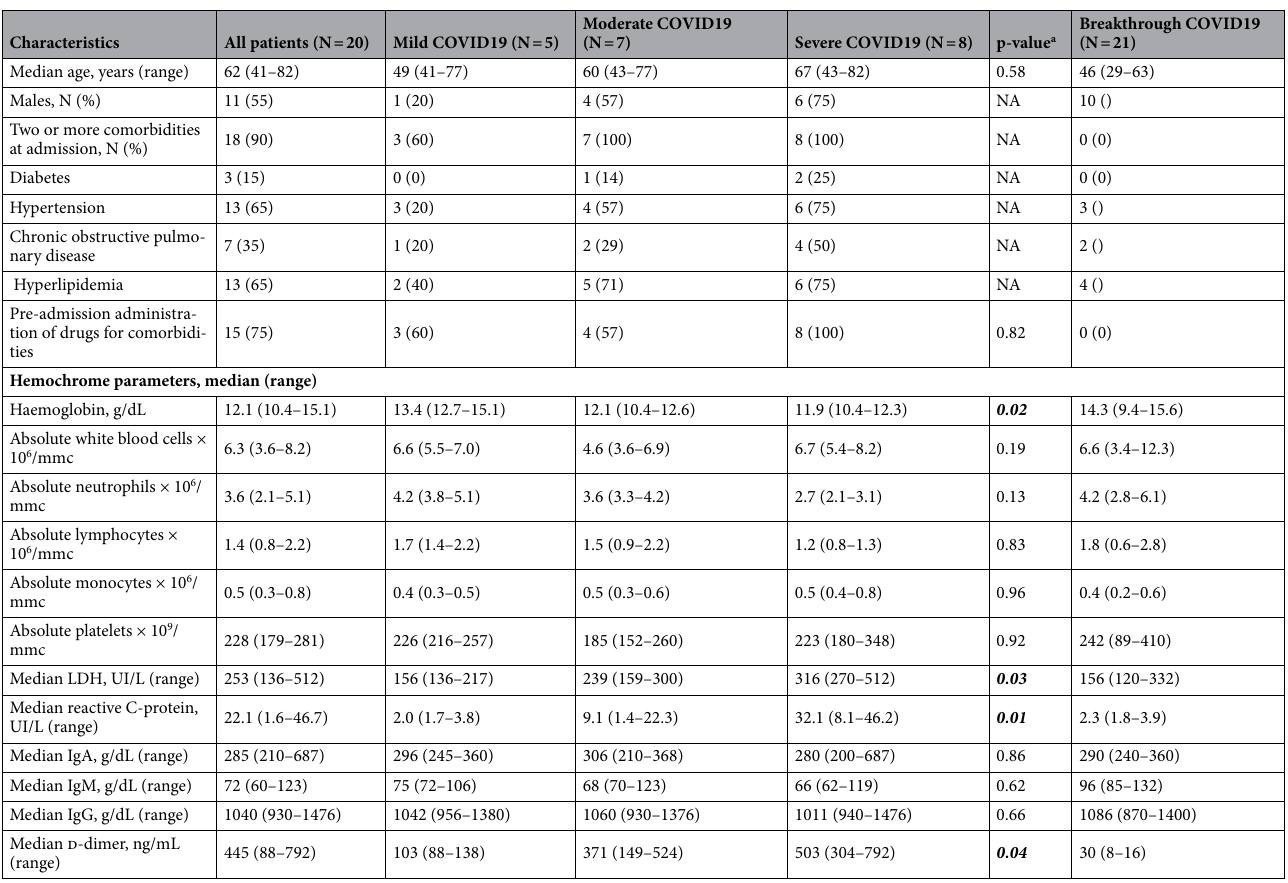
Table 1. Descriptive statistics of the study population at baseline of their COVID-19 diagnosis. a Based on ANOVA test for the comparison of findings in COVID-19 patients; p-values < 0.05 are indicated in bold font. Results are reported as median and interquartile (IQ)